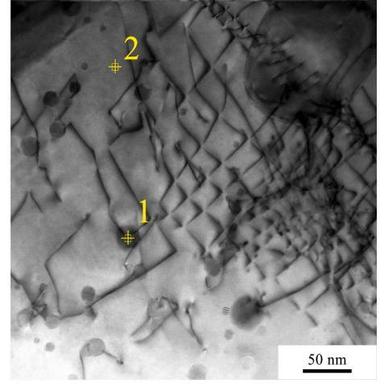
A TEM image of ODS Eurofer showing large and small nano-precipitates interacting with dislocations.